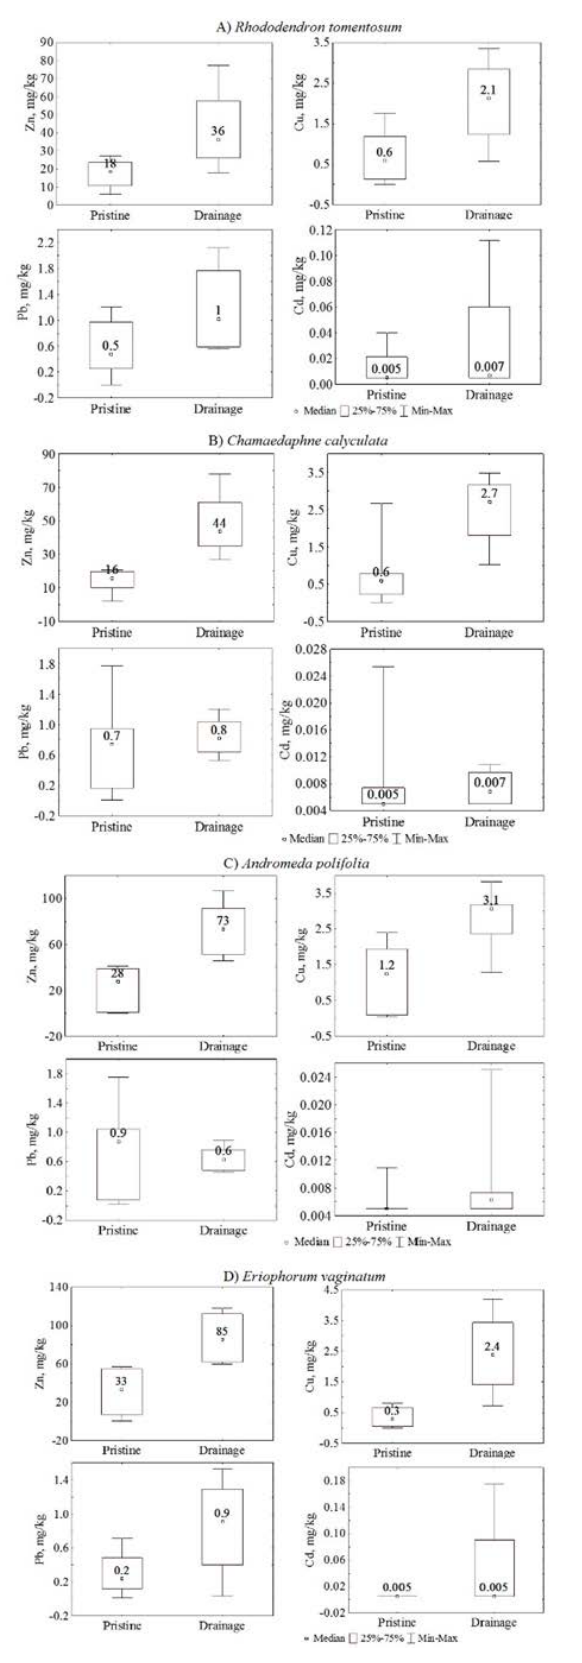
Figure 3. Element content of plants (dry weight, mg/kg) in pristine and drained areas of the